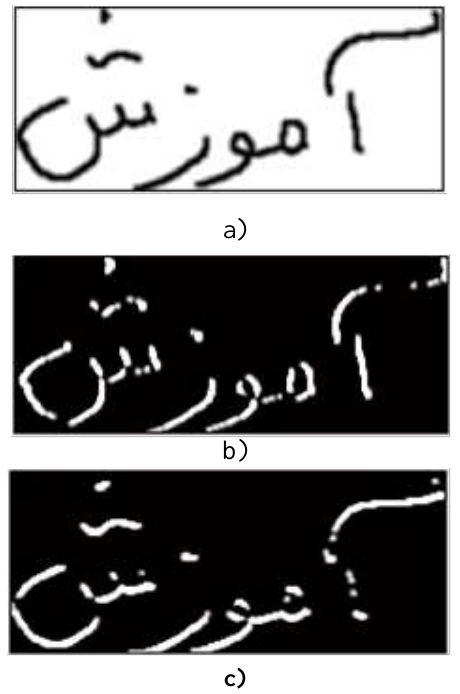
Figure4. a) Input word image. b) Vertical derivative